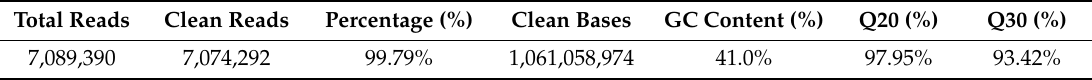
Table 2. Sequencing information of L. sakei via Illumina.